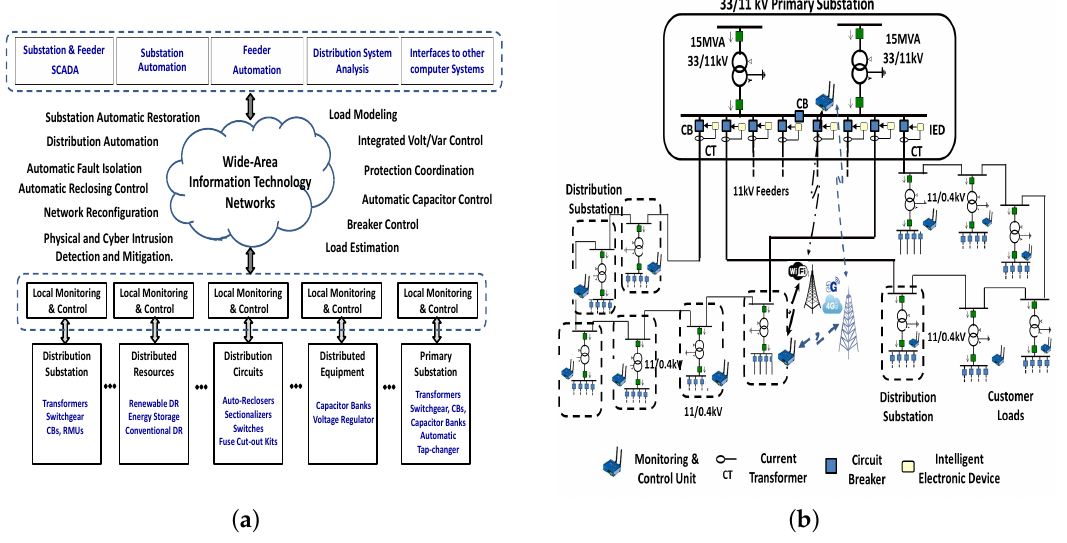
Figure 1. Future distribution system. ( a ) integrating local monitoring/control for future distribution functions; ( b ) a conventional distribution system upgraded towards a smart